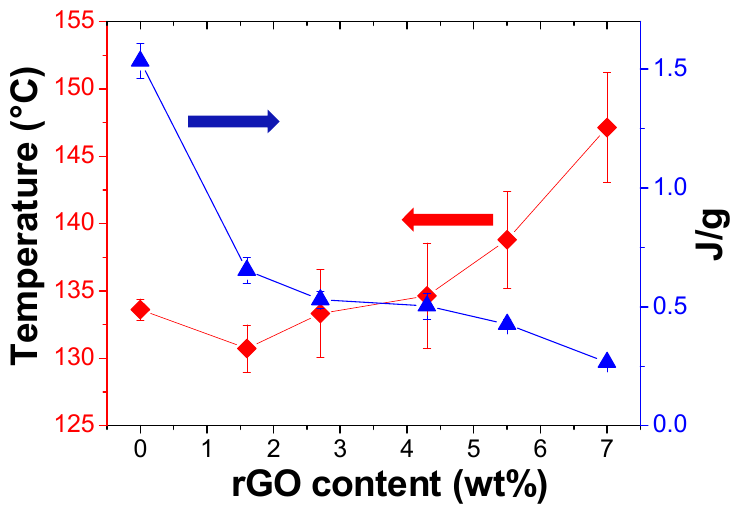
Figure 7. Temperature peak ( ♦ ) and enthalpy ( ▲ ) where most of the DA adducts are cleaved for all the series of PKFU/BISM/rGO composites at different rGO content.